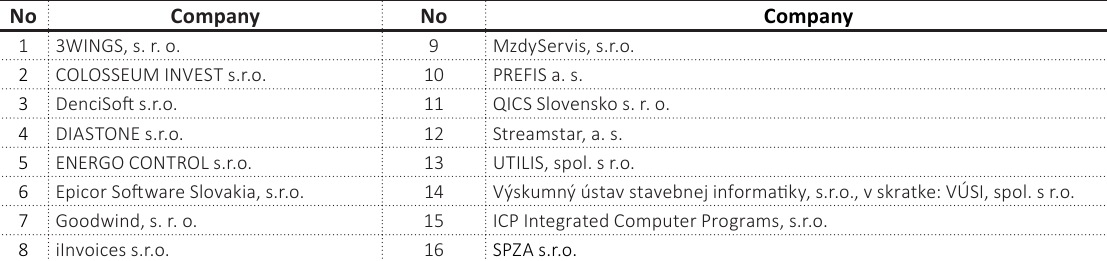
Table A1. Reporting data of 16 Slovak software development companies